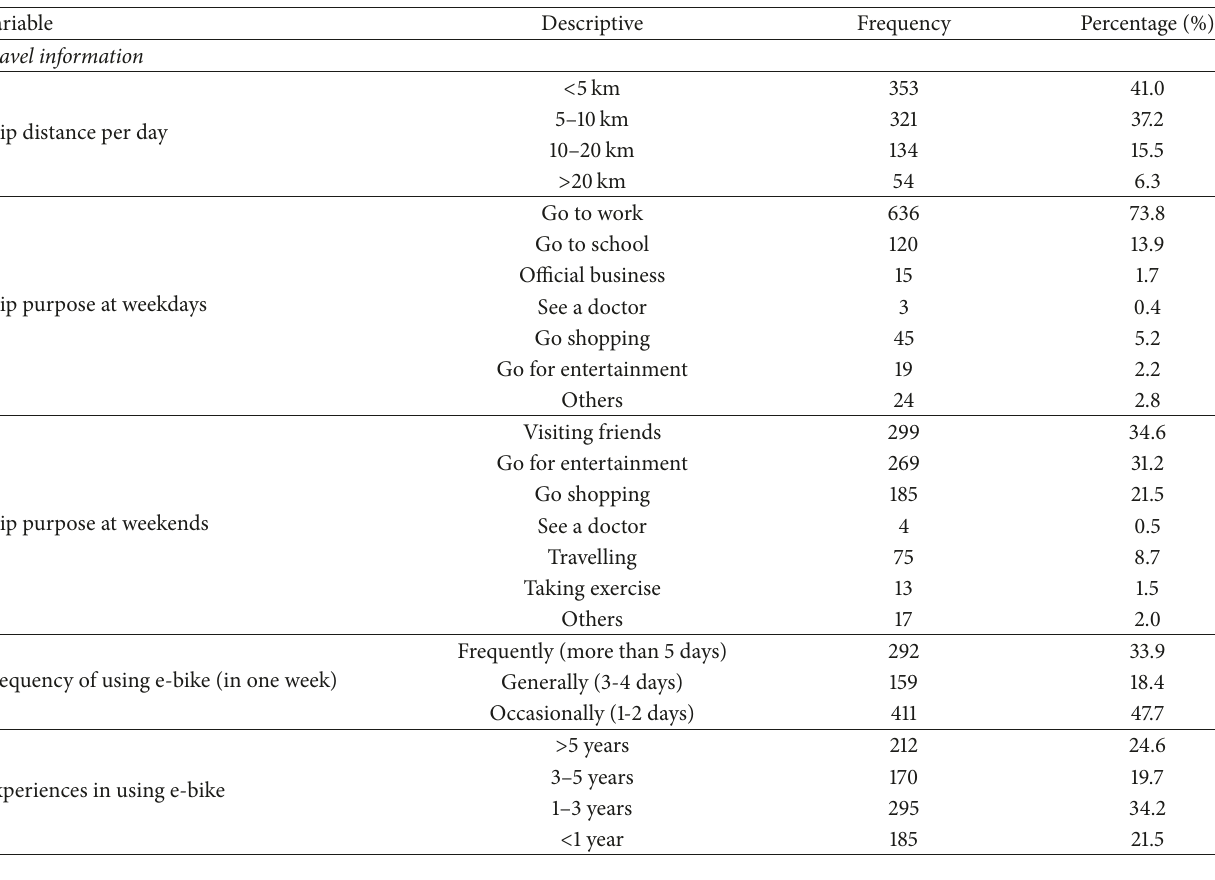
Table 3: Descriptive statistics for travel